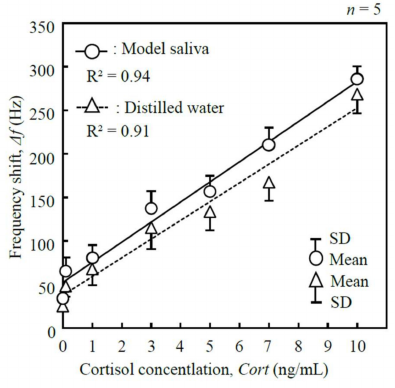
Figure 11. Calibration curves of standard cortisol samples in distilled water and model saliva as solvents (1.402 MHz measured frequency, 200 µ L sample